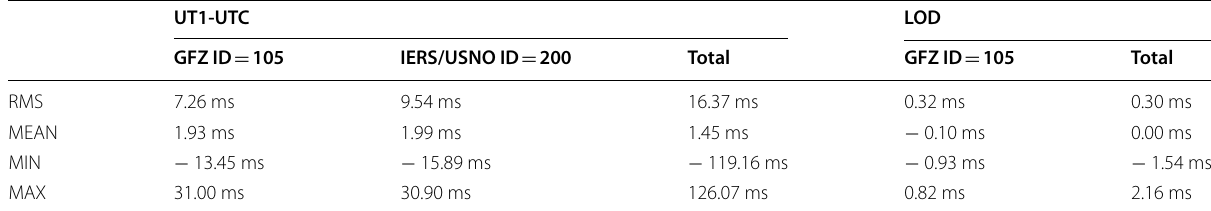
Table 2 Summary of UT1-UTC and LOD predictions accuracy from the differences between submission and reference series (IERS 14 C04). Values marked as Total are computed for submissions from all participants treated as one participant to show general performance of the forecasts